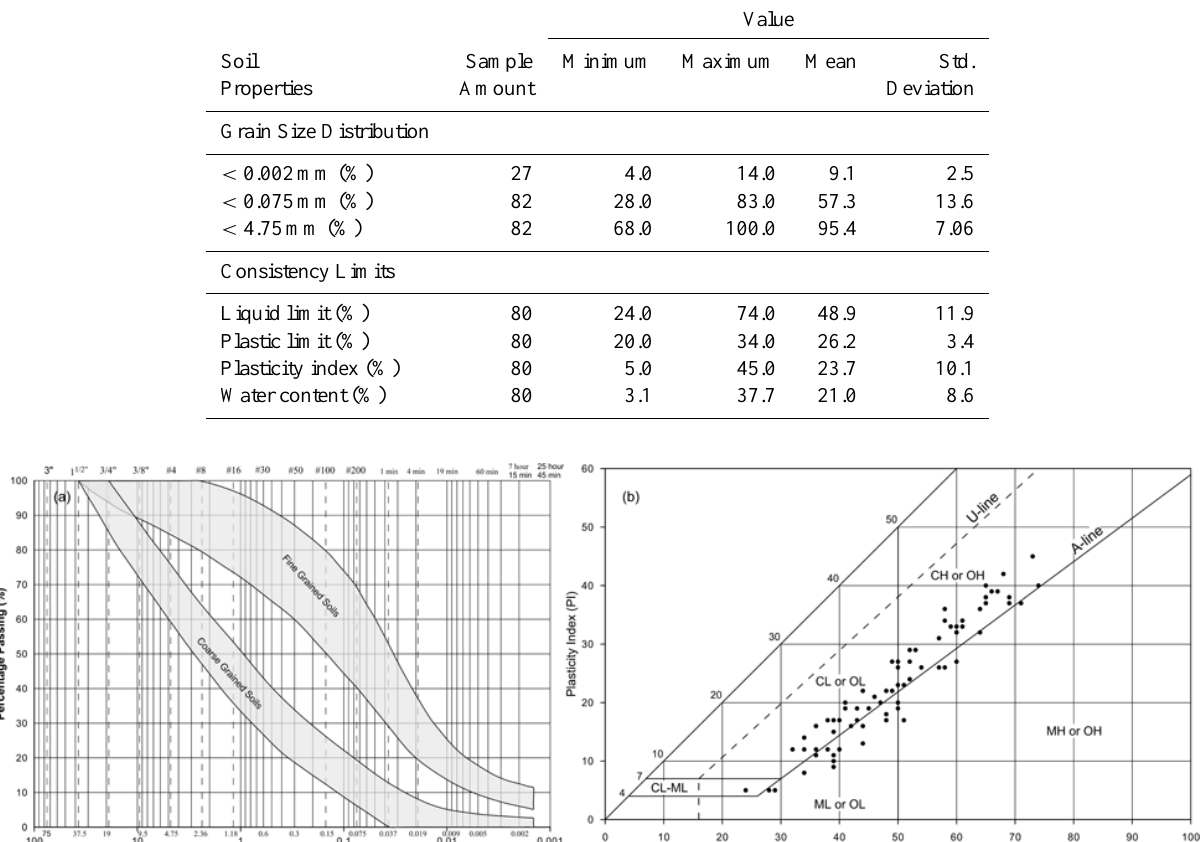
Table 2. Statistical summary of the definition test results.